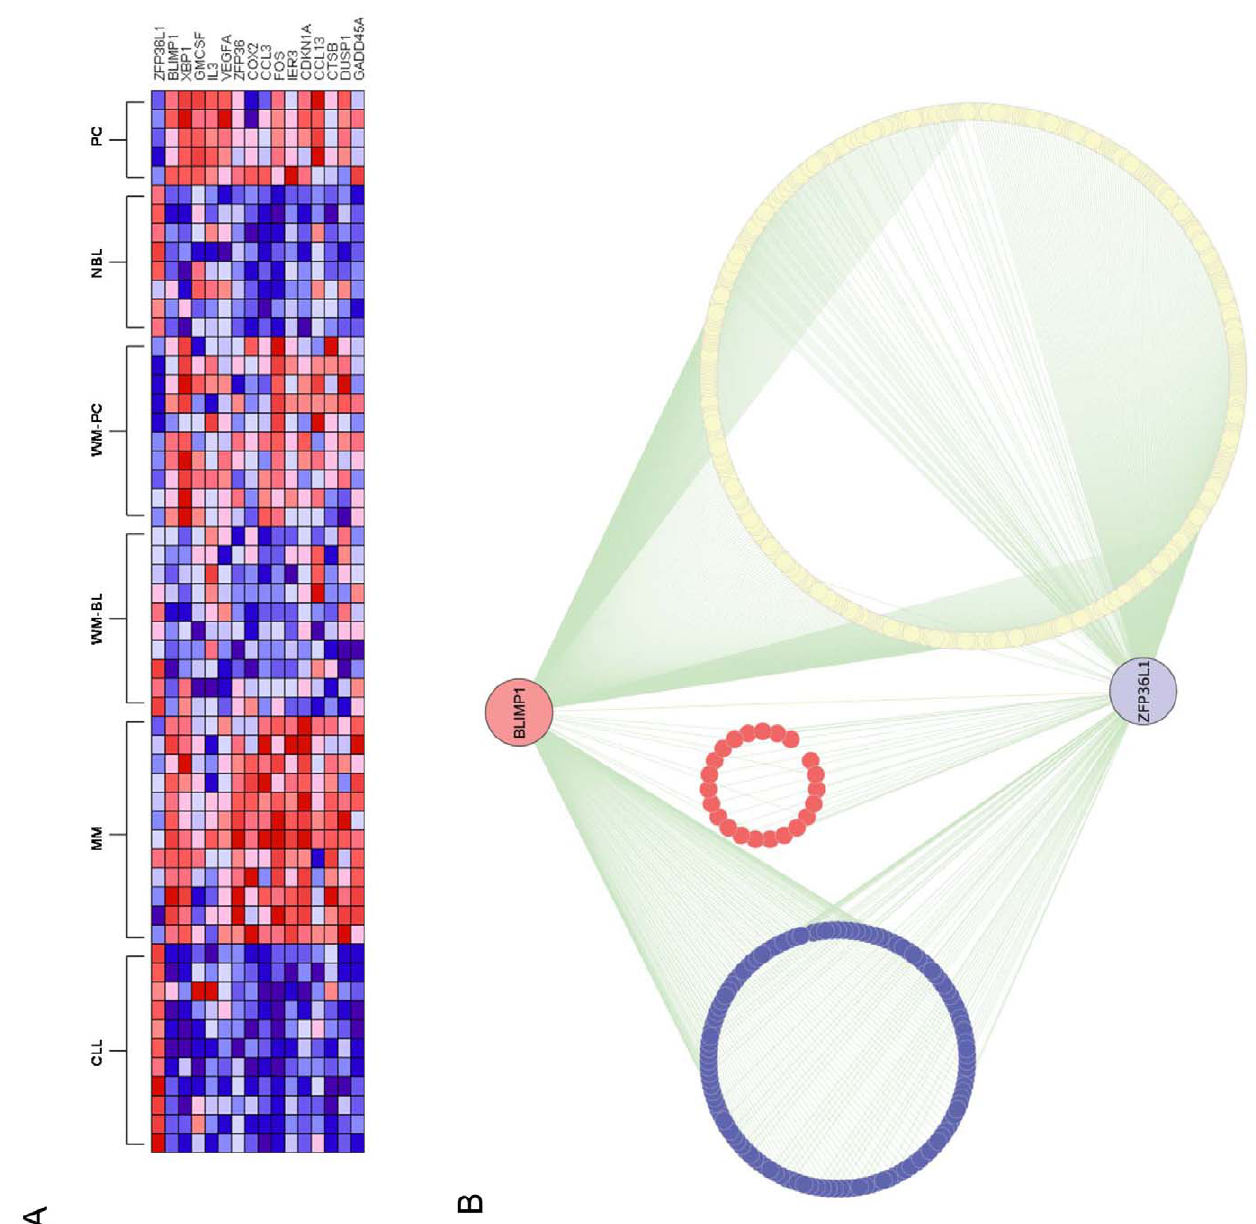
Figure 6. Microarray expression profile and ARACNe network of ZFP36L1. (A) Heat map expression profile of known ZFP36L1 target genes in terminal B cell differentiation. The profiles are compared with the reference genes, ZFP36L1, BLIMP1 and XBP1 (first three rows). GMCSF, VEGFA and IL-3 are validated ZFP36L1 targets; the remaining genes have been validated for ZFP36 [4]. Data was taken from GEO Accession number GSE 6691 [29]. Red indicates high and blue, low expression. Key: CLL: B chronic lymphocytic leukemia, MM: multiple myeloma, WM-BL: Waldenstrom’s macroglobulinemia B cells, WM-PB: Waldenstrom’s macroglobulinemia plasma cells, NBC: normal B cells, PC: normal plasma cells. (B) Graphical representation of the ARACNe network for BLIMP1 and ZFP36L1. Nodes representing the BLIMP1 and ZFP36L1 hubs are shown enlarged. Only first neighbours of these hubs are shown in the module. Nodes representing inferred BLIMP1 targets (significantly up-regulated in normal B cells) are blue; nodes representing inferred ZFP36L1 targets (significantly up-regulated in normal plasma cells) are red. Network graphics were generated as group attribute layout using Cytoscape version 2.6.0. [35]. doi:10.1371/journal.pone.0052187.g006 empty vector pSicoR virus control BCL1 cells in the absence of coR.zfp36l1.RNAi2) were designed to target and knock-down expression of ZFP36L1. As shown in Fig. 4, transduction with both cytokines although this effect did not reach statistical significance pSicoR.zfp36l1.RNAi1 and pSicoR.zfp36l1.RNAi2 was effective (Fig. 5A). Similarly, no significant effect on cell proliferation was in down-regulating endogenous ZFP36L1 in BCL1 cells at both seen following cytokine induction in pSicoR.zfp36l1.RNAi-trans- duced cells (Fig. 5B). However, knock-down of ZFP36L1 induced protein and mRNA levels (Fig. 4A and B). pSicoR.zfp36l1.RNAi- transduced BCL1 cells proliferated less than wild-type, scramble or a significant increase in IgM production in the absence of